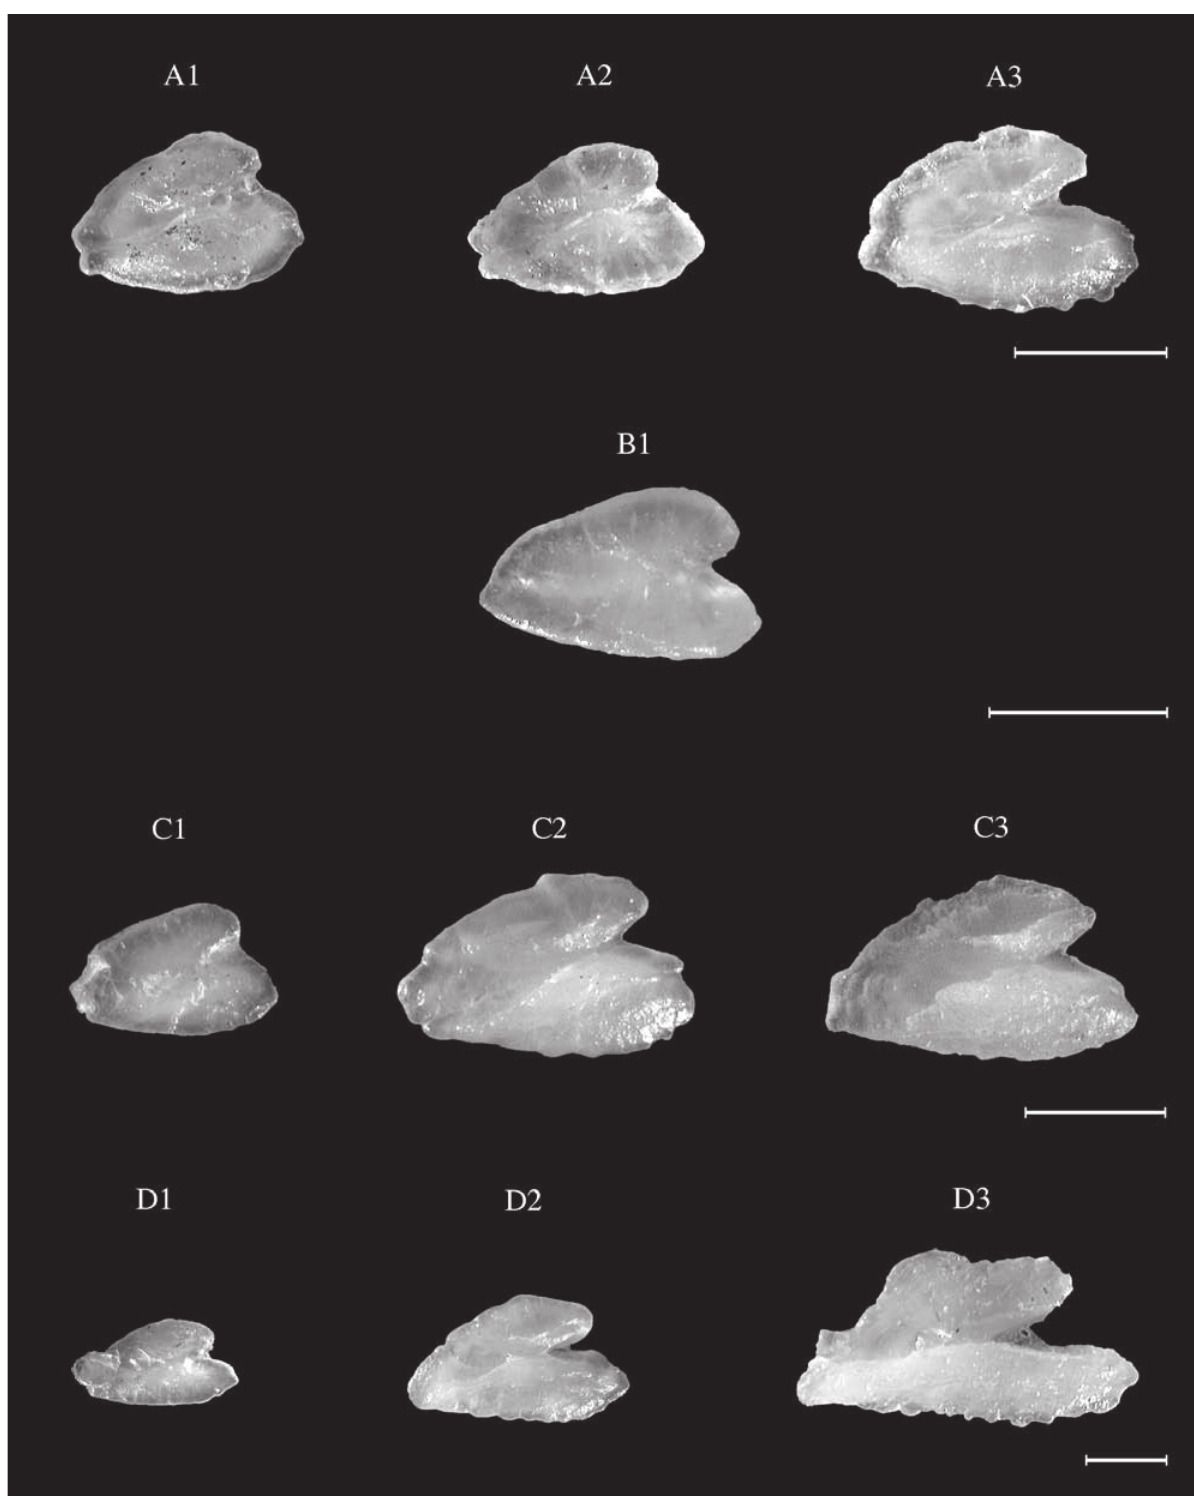
Fig. 71. – Symphodus ocellatus (WM). TL: A1, 7.0 cm; A2, 7.5 cm; A3, 9.0 cm. Symphodus roissali (WM). TL: B1, 8.0 cm. Symphodus rostratus (WM). TL: C1, 6.0 cm; C2, 10.0 cm; C3, 11.0 cm. Symphodus tinca (WM). TL: D1, 8.5 cm; D2, 16.0 cm; D3, 32.0 cm. Scale bar = 1